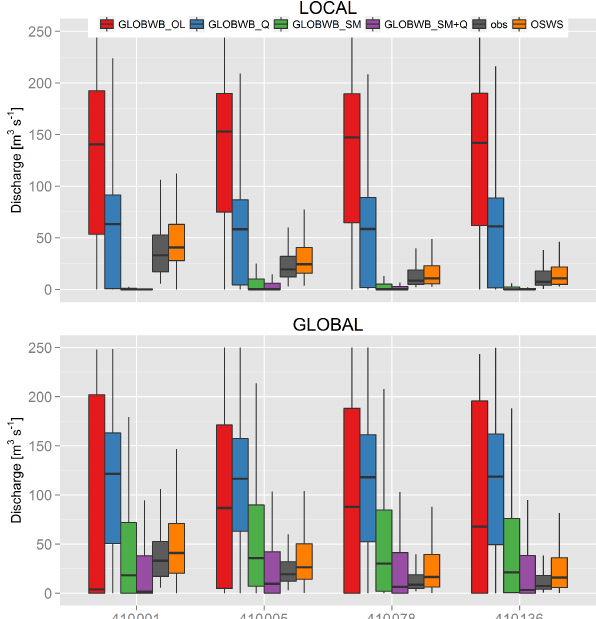
Figure 10. Boxplots of streamflow estimates at station nos. 410001, 410005, 410078 and 410136 in the Murrumbidgee River. The up- per panel shows streamflow when local data are used as model forc- ing. Streamflow obtained with the global forced models is shown in the lower panel. Boxplots of each panel illustrate the first and third quantile ranges (box), the median (dark line) and the maximum– minimum range (whiskers) of streamflow